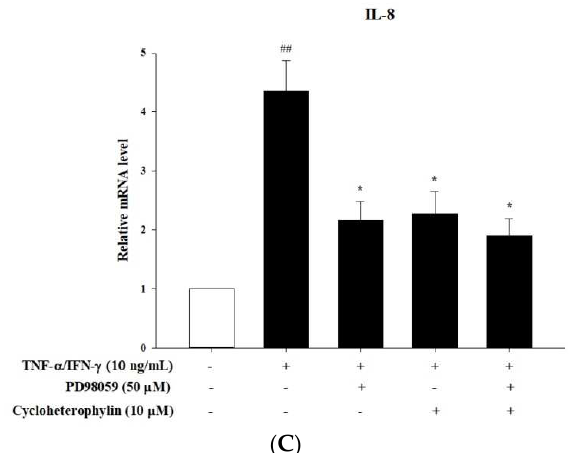
Figure 4. The anti-inflammatory effects of cycloheterophyllin on the TNF-α/IFN-γ-induced inflam- matory response with/without pretreatment of MAPK inhibitor, PD98059, in HaCaT cells. HaCaT cells were pretreated with PD98059 (50 μM), cycloheterophyllin (10 μM), or their combinations for 1 h, and then cells were treated with TNF-α/IFN-γ (10 ng/mL) for 30 min. Total RNA was isolated and mRNA expression levels of ( A ) IL-1β, ( B ) IL-6, and ( C ) IL-8 were determined using qPCR. Values represent mean ± SEM from three independent experiments. ## p < 0.01 compared to untreated conditions; * p < 0.05 compared to TNF-α/IFN-γ treated conditions.